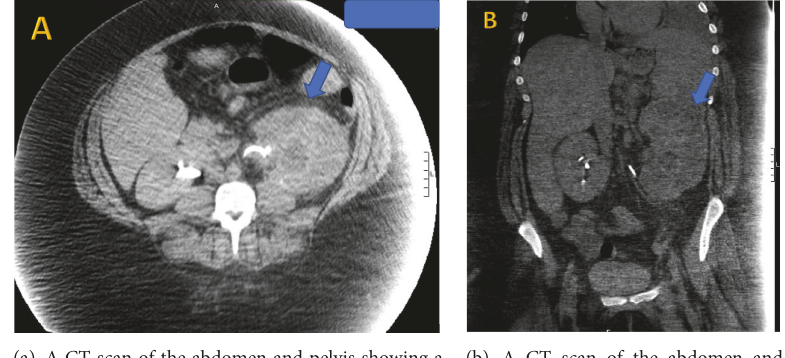
xanthogranulomatous pyelonephritis (arrow) kidney with appearance suggestive of